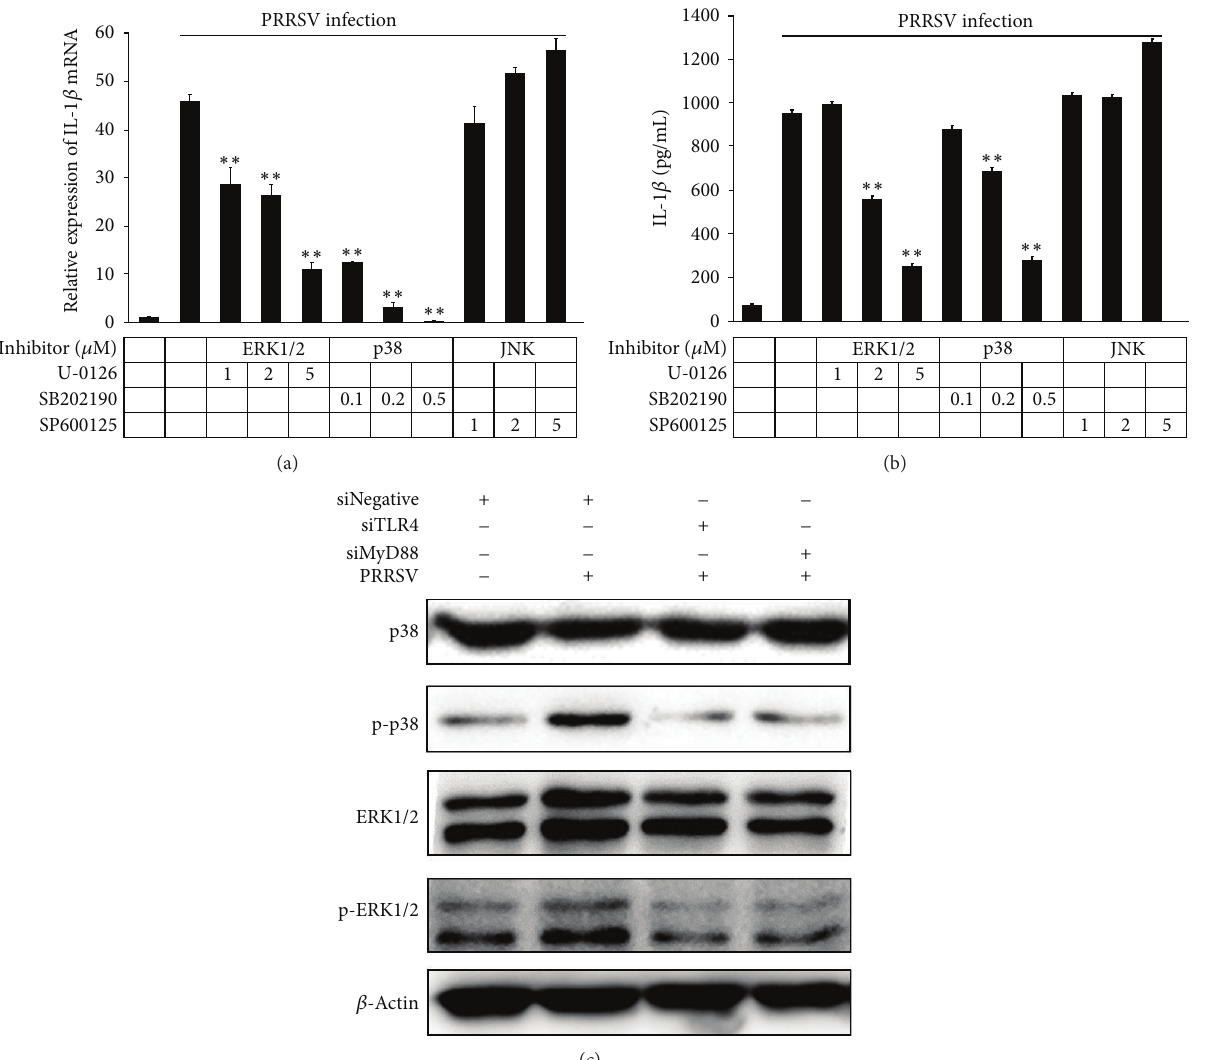
Figure 6: MAPK p38 and ERK1/2 are critical for PRRSV-induced IL-1 𝛽 production in PAMs. Experiments were performed similar to those described in Figure 3 except that ERK1/2 inhibitor (1, 2, and 5 𝜇 M), p38 MAPK inhibitor (0.1, 0.2, and 0.5 𝜇 M), or JNK inhibitor (1, 2, and 5 𝜇 M) was used. Cells and supernatants were then harvested and analyzed by IL-1 𝛽 -specific real-time RT-PCR (a) and ELISA (b), respectively. ∗∗ 𝑃 < 0.01 compared with DMSO plus PRRSV